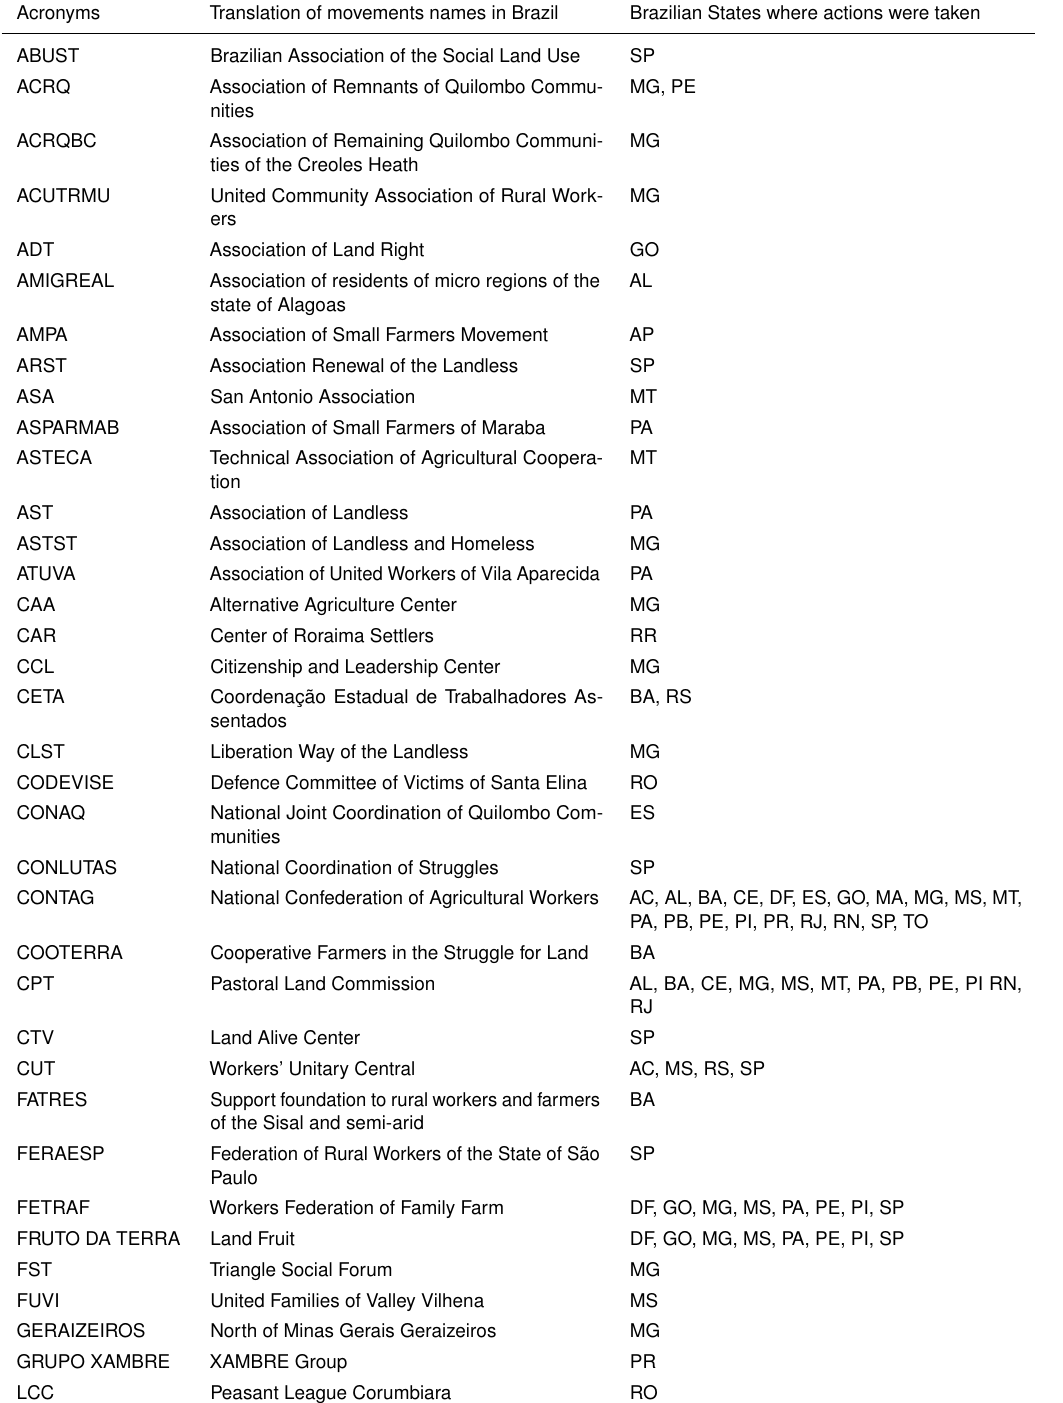
Table A1. Socio-territorial Movements and Brazilian States in which they operate